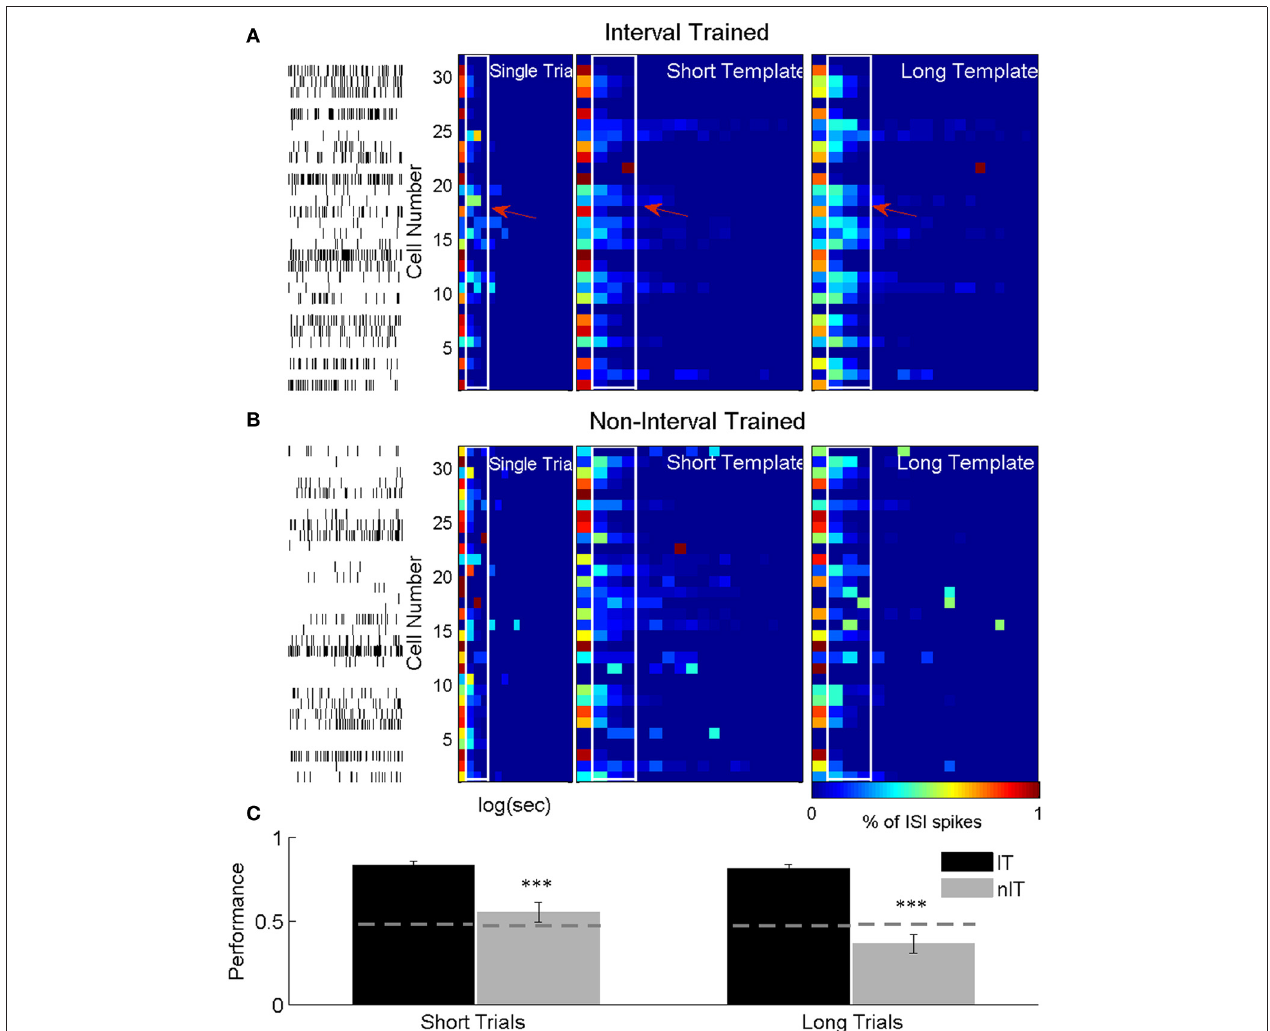
FIGURE 7 | ISIh-based classification press duration. (A) ISIh-based classification of single short duration trial for an IT animal. (B) ISIh-based classification of single short duration trial for a nIT animal. For both (A) and (B) , the left most panel are the single neuron spike times (one neuron per row) the single short duration trial. The next panel is the binned ISI histograms for the ensemble firing (normalized to the peak bin) for the same trial. The next two panels show the average population ISI histograms for either all of the remaining the short trials or all of the long trials (right most